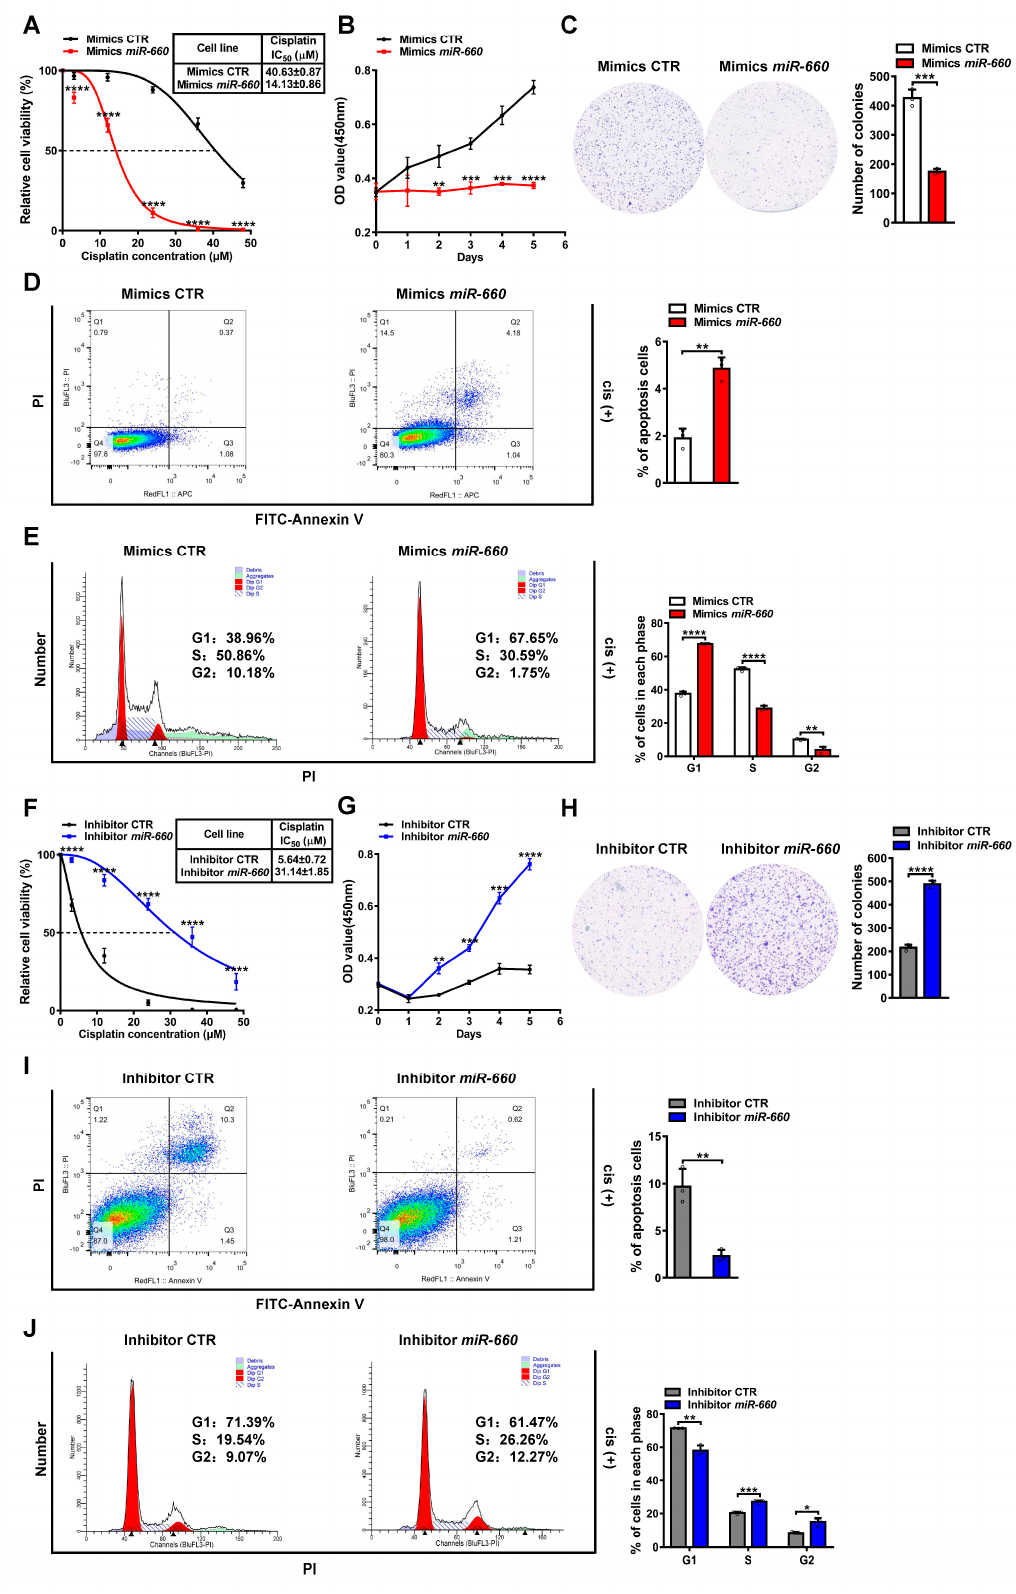
Figure 2. MiR - 660 enhances cisplatin sensitivity in LUAD cells. ( A ) Comparison of cisplatin IC 50 values between A549/CDDP cells transfected with mimics of CTR and miR - 660 mimics. ( B – E )